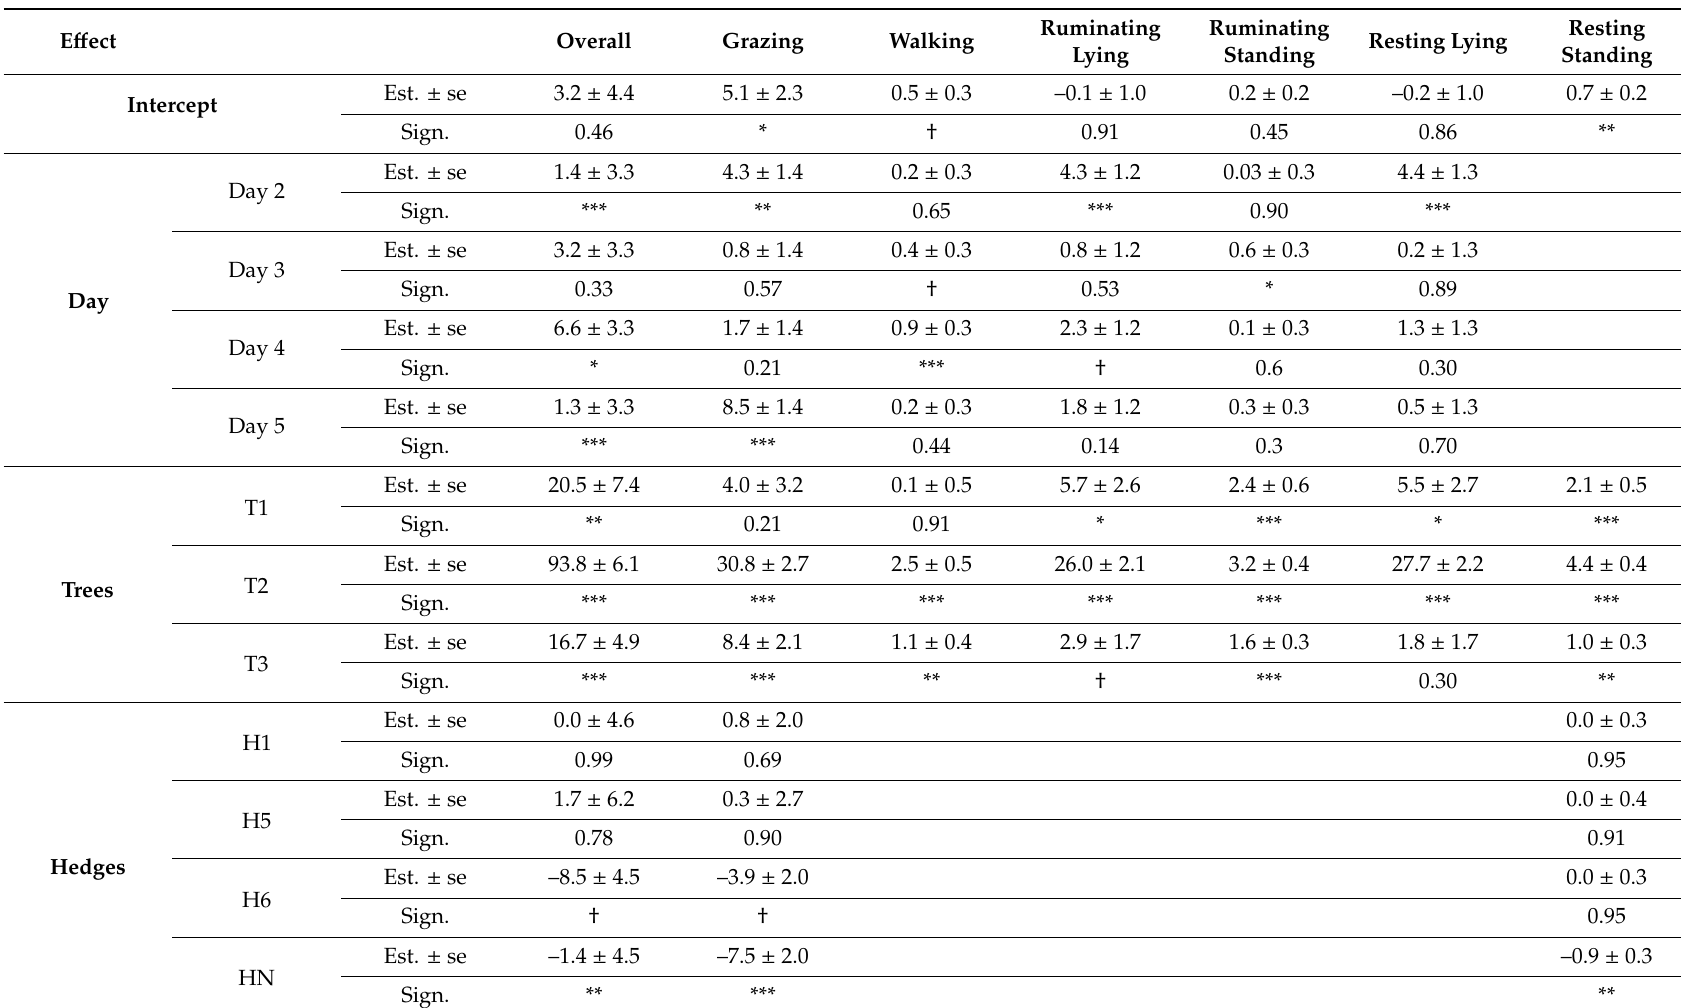
Table A4. Estimates and significance levels associated with the pasture characteristics and the day of grazing for the permanent grassland. E ff ect Overall Grazing